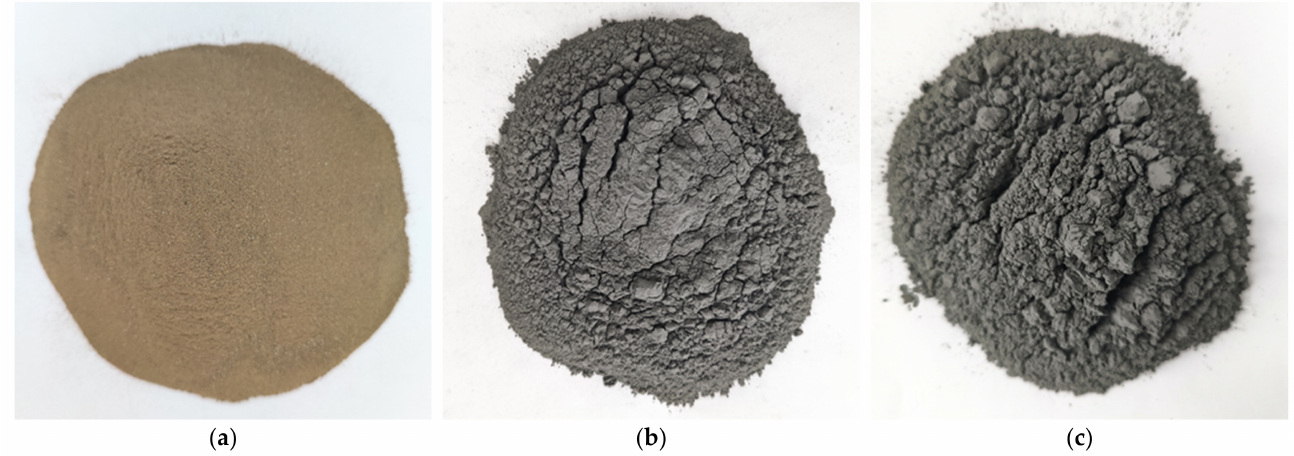
Figure 1. Digital images: ( a ) loess; ( b ) desulfurization ash; and ( c ) fly ash.